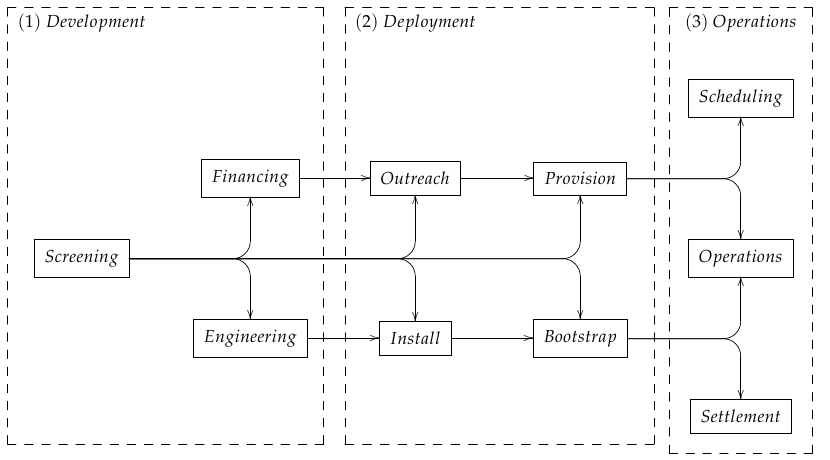
Figure 2. TESS program